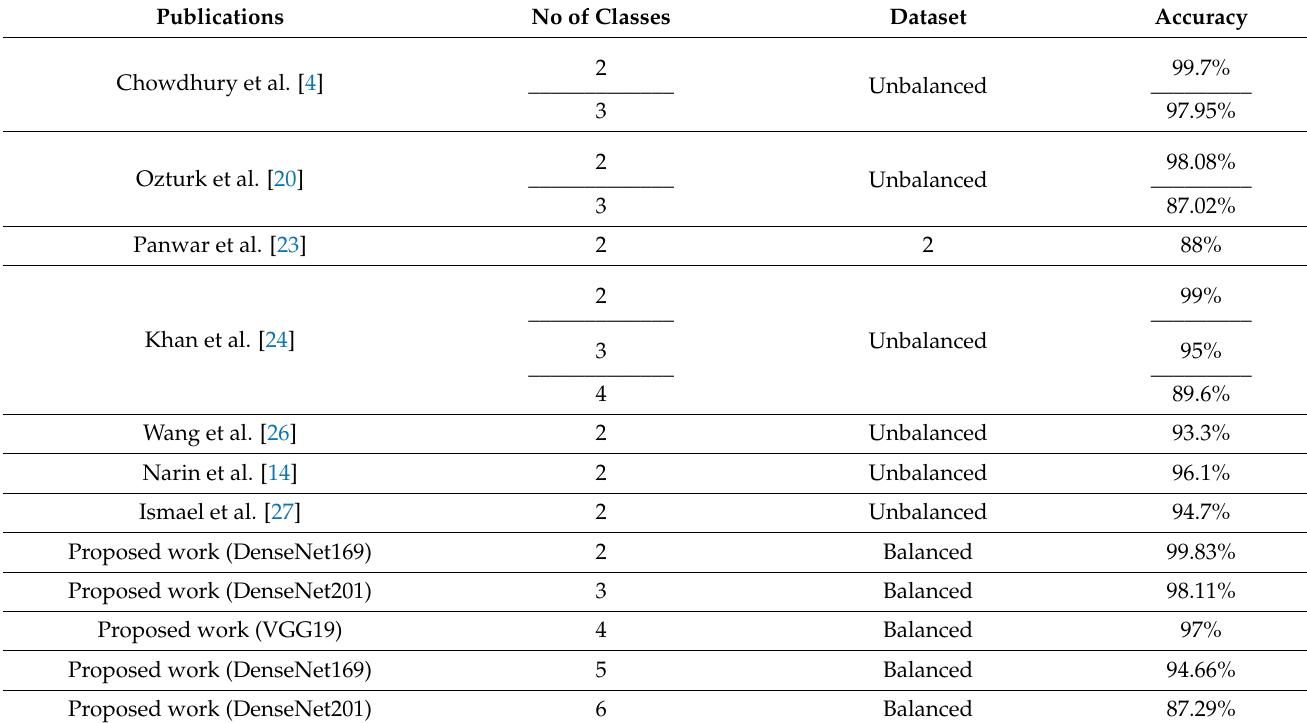
Table 15. Comparison of proposed approach with the existing